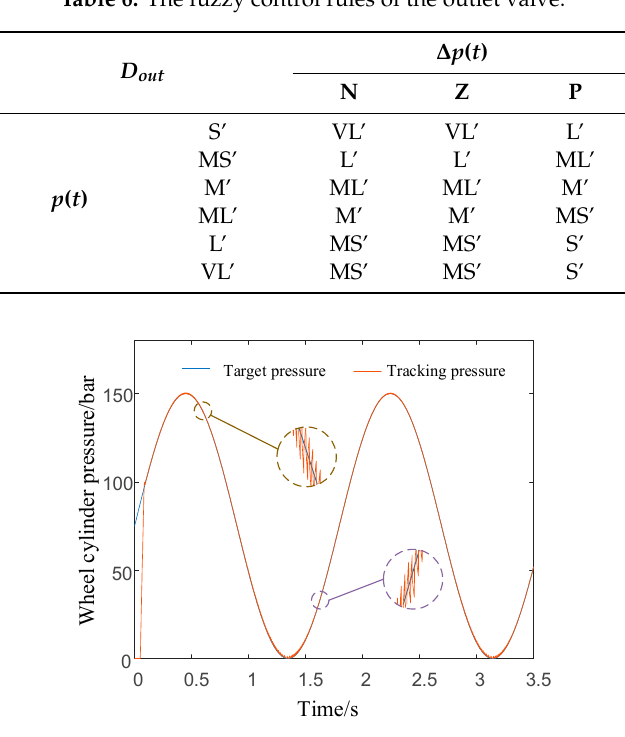
Figure 6. The response of the wheel cylinder with a sinusoidal input.